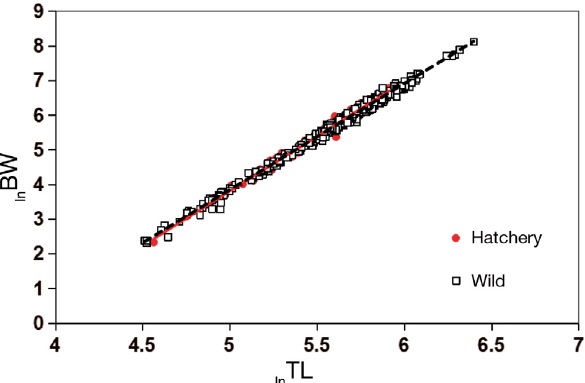
Fig. 2. Linear regression between total length (TL) and body weight (BW) for hatchery ( D ) and wild ( h ) mandarin fish Siniperca chuatsi in Xiaosihai Lake